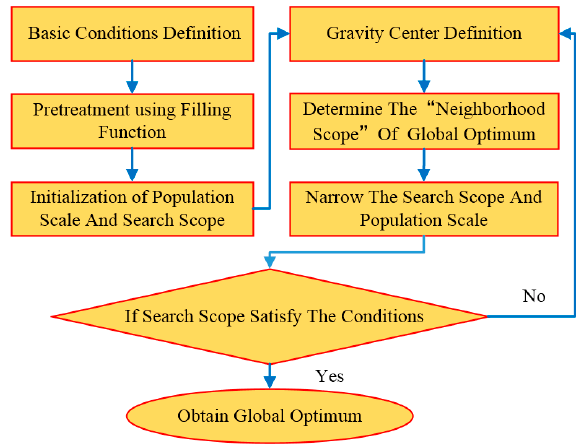
Figure 9. Flowchart of the GCNA.